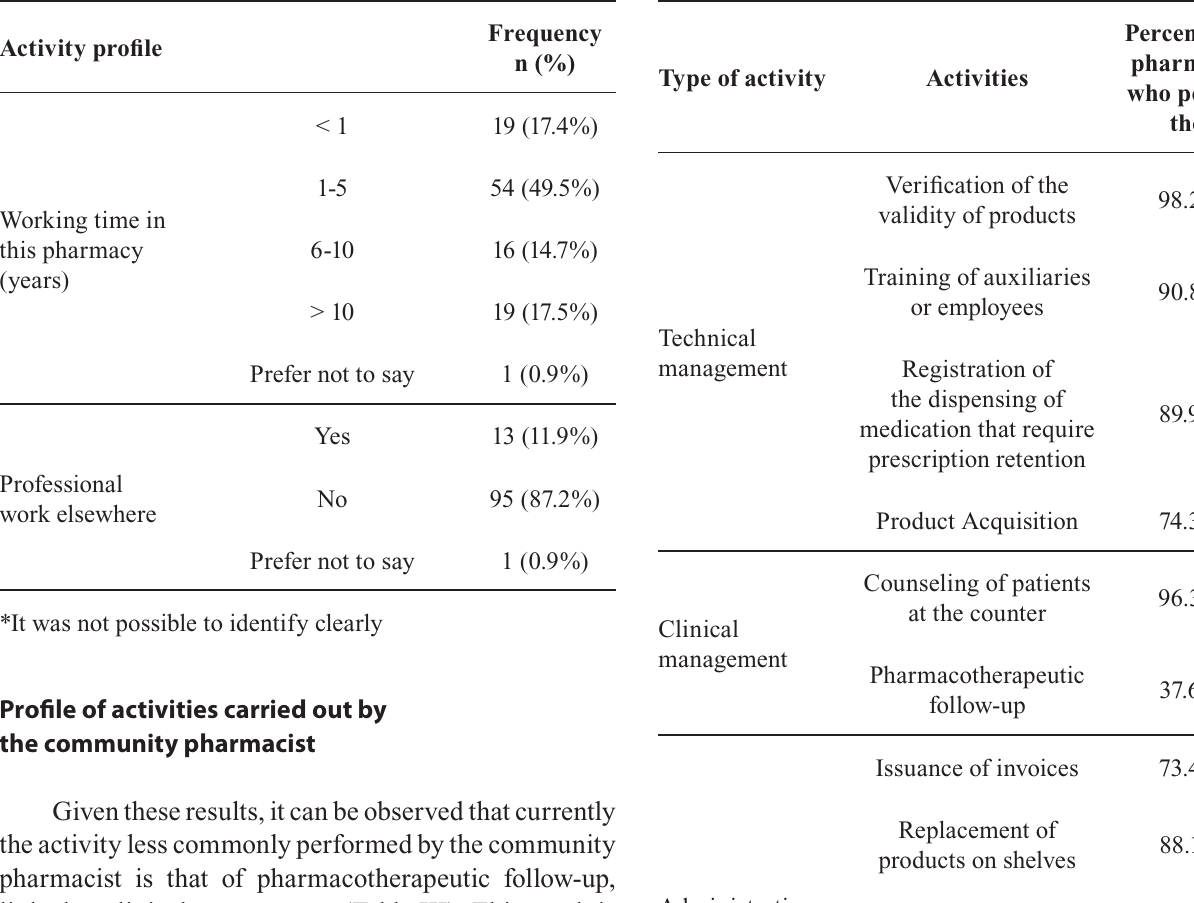
TABLE II - Professional activity profile of pharmacists in charge of community pharmacies in the metropolitan region of Belo Horizonte-MG (n = 109; 2017)